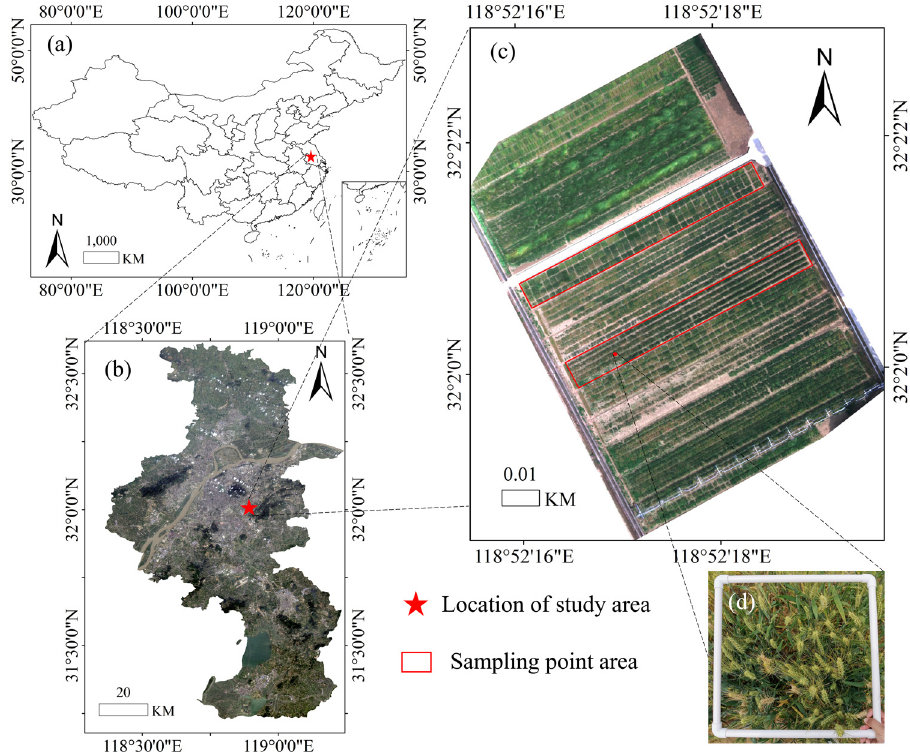
Figure 1. Overview of the study area: ( a ) the location of Nanjing City; ( b ) the location of the experimental site; ( c ) multispectral image of experimental site acquired by UAV; ( d ) sampling range of canopy data.